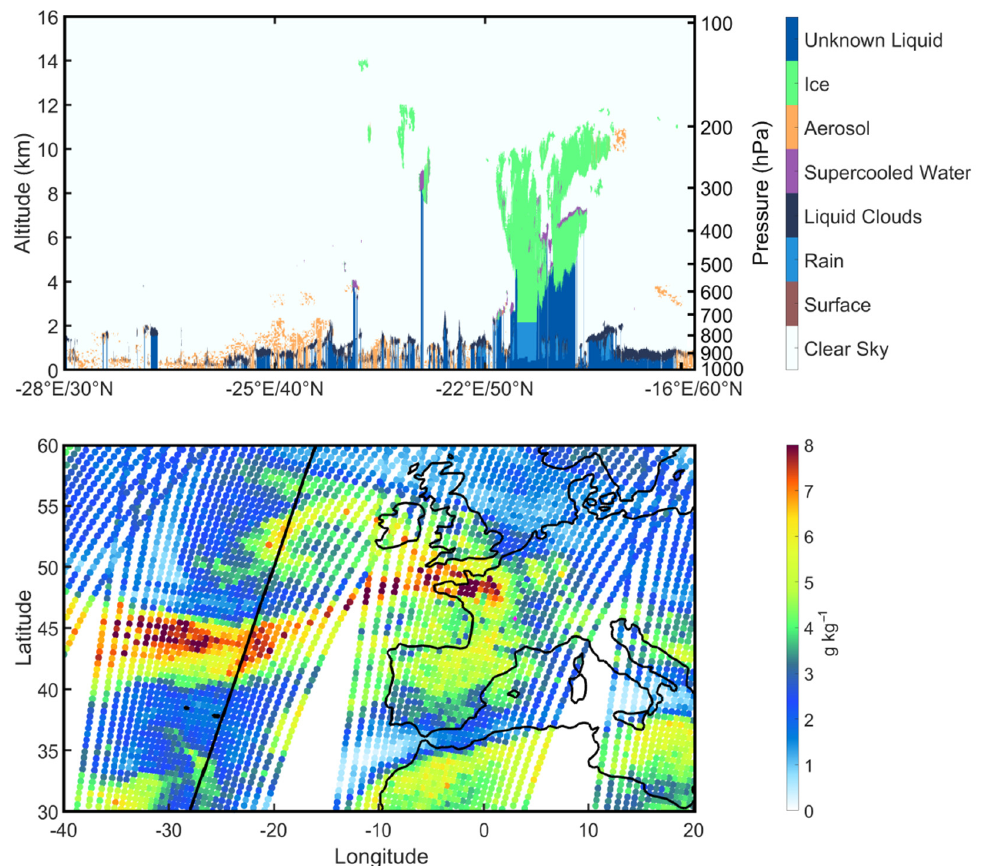
Figure 7. DARDAR simplified characterization on 25 August 2014 at 04 UT ( top ), and WVMR retrieved by AIRS at 700 hPa on 25 August from 00 to 06 UT ( bottom ). The black line represents the localization of the DARDAR cross-section.